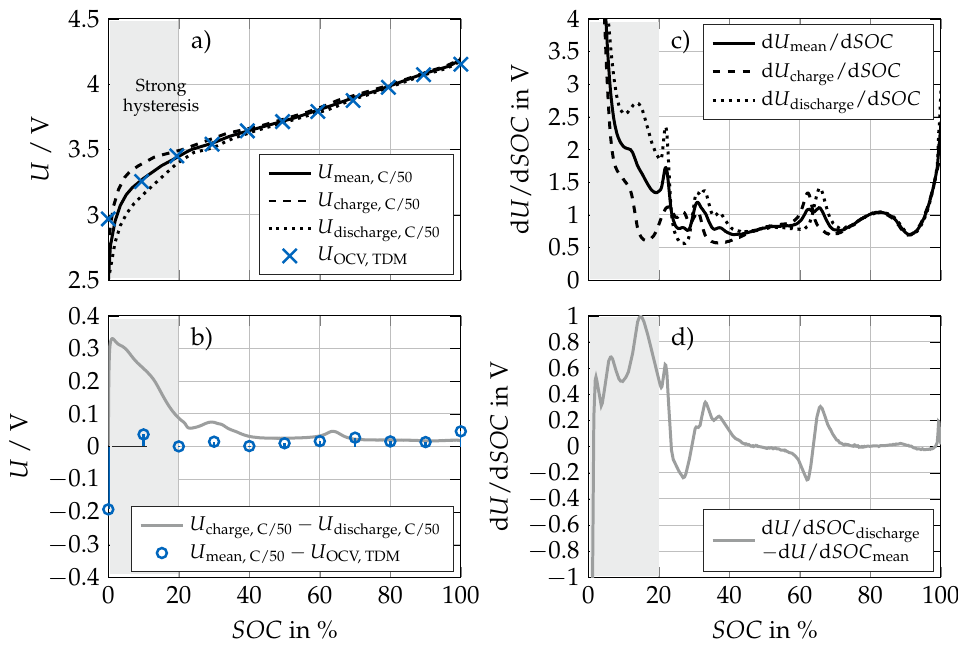
Figure 2. ( a ) Measured pseudo-OCV curve during discharging and subsequent charging with C/50 at 20°C and the corresponding mean curve. Additionally, the relaxed voltage U OCV, TDM , which was measured right before the discharge pulse I P after three weeks of relaxation, are plotted. ( b ) Difference between the charge and discharge pseudo-OCV and difference between mean pseudo-OCV and U OCV, TDM ( c ) Differential voltage of the pseudo-OCV curves. ( d ) Difference between the differential voltage of the discharge and the mean pseudo-OCV